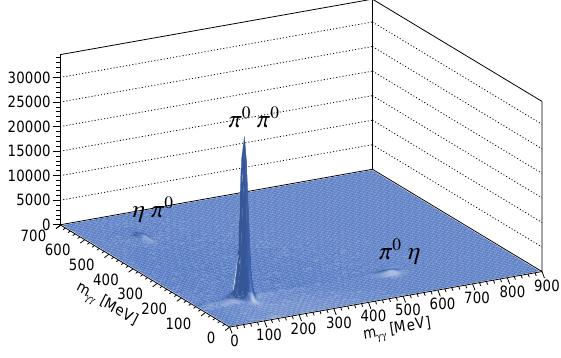
Figure 1. Invariant mass of one photon pair versus the other after the angular cuts and a cut on the missing proton